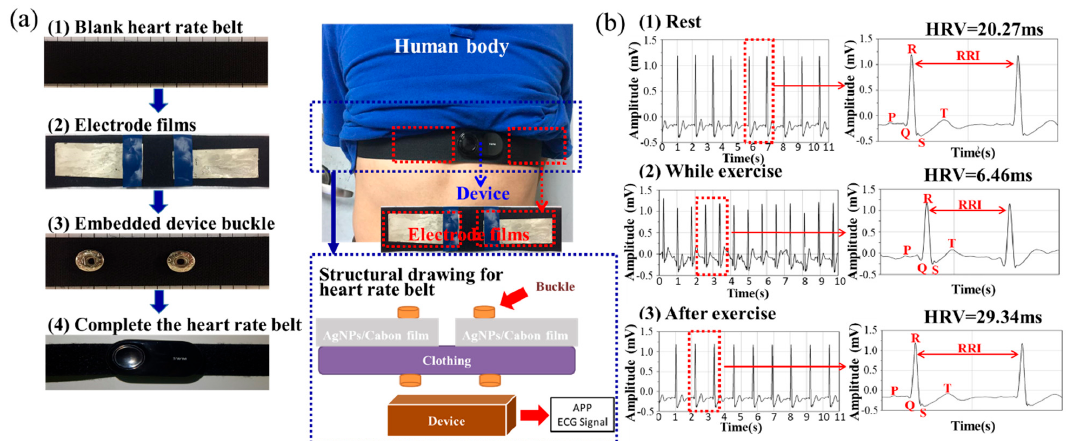
Figure 6. Electrodes of electrocardiograms (ECG) sensors were made using AgNPs/PIB-POE-PIB/GO hybrid thin films, and ECG monitoring was conducted. ( a ) Assembly of the heart rate monitoring belt using AgNPs/PIB-POE-PIB/GO hybrid thin films, and ( b ) Complete and satisfactory signals for QRS-complexes and P- and T-waves in ECGs when the subject was at rest, exercising, and after the exercise.